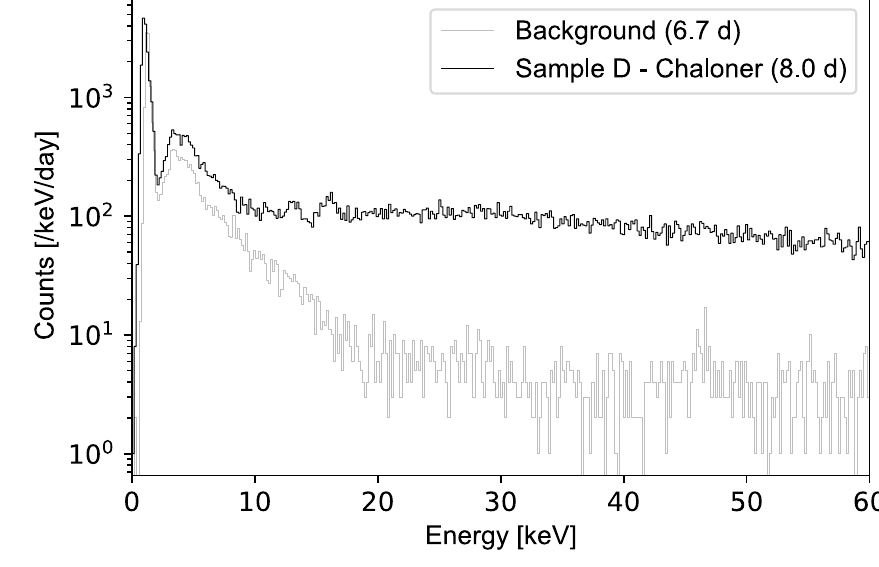
Fig. 11 Spectra of open system